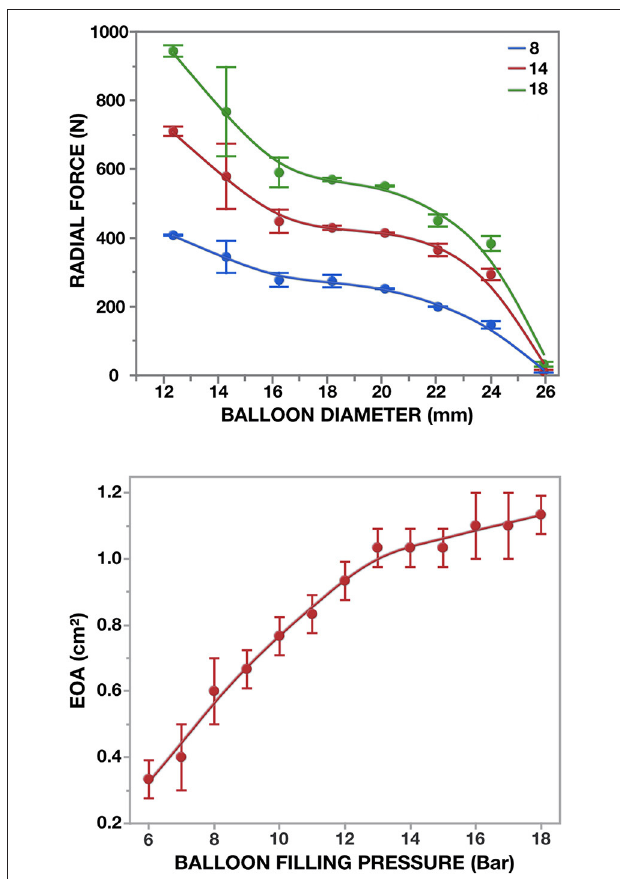
FIGURE 11 | Radial force of the 26mm non-occlusive delivery device for [M]-size TAVR. Three different inflation pressures were blotted against balloon-diameters (top): 8 bar (onset of non-occlusiveness); 14 and 18 bar ( n = 3 × 3). In the pulse duplicator, effective orifice areas were determined against restricted balloon inflation